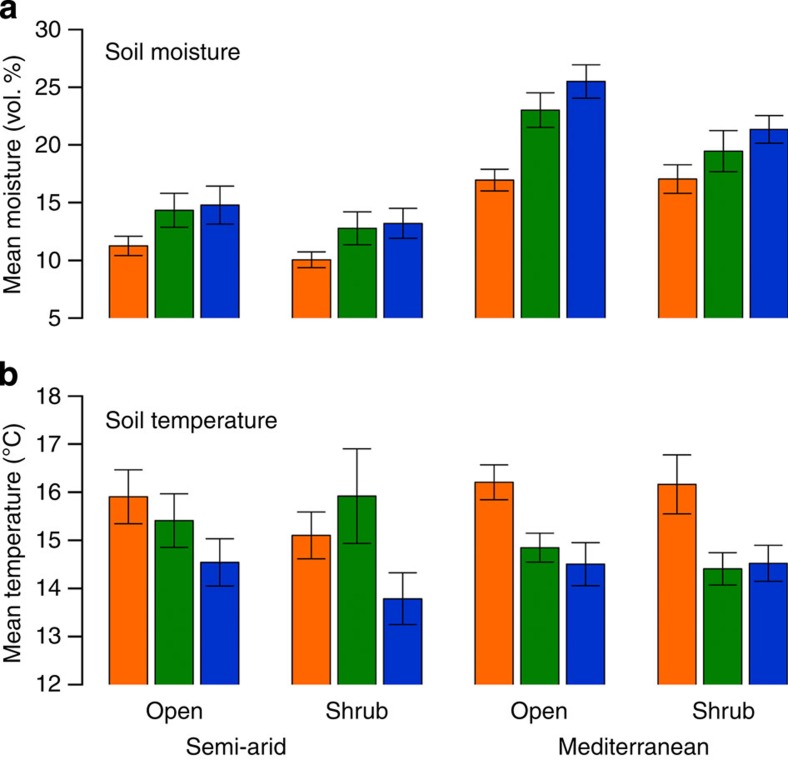
Average soil moisture and temperature in rainfall manipulation treatments.Means across years (±s.e.) are given during the first eight study years in two sites, two microhabitats (under shrubs, in open areas) and three rainfall manipulation treatments (dry—orange, control—green, wet—blue). Linear Mixed Models were used to compare the treatments. Treatment effects on soil moisture (a) were significant in all the cases and in the expected direction with soil moisture being significantly lower in the drought treatment, intermediate in control plots and highest in irrigated plots. Temperatures (b) were also increased in drought plots and slightly decreased in irrigated plots (except for plots under shrubs in the semi-arid), adding to the realism of the climate manipulations and confirming the robustness of the results.